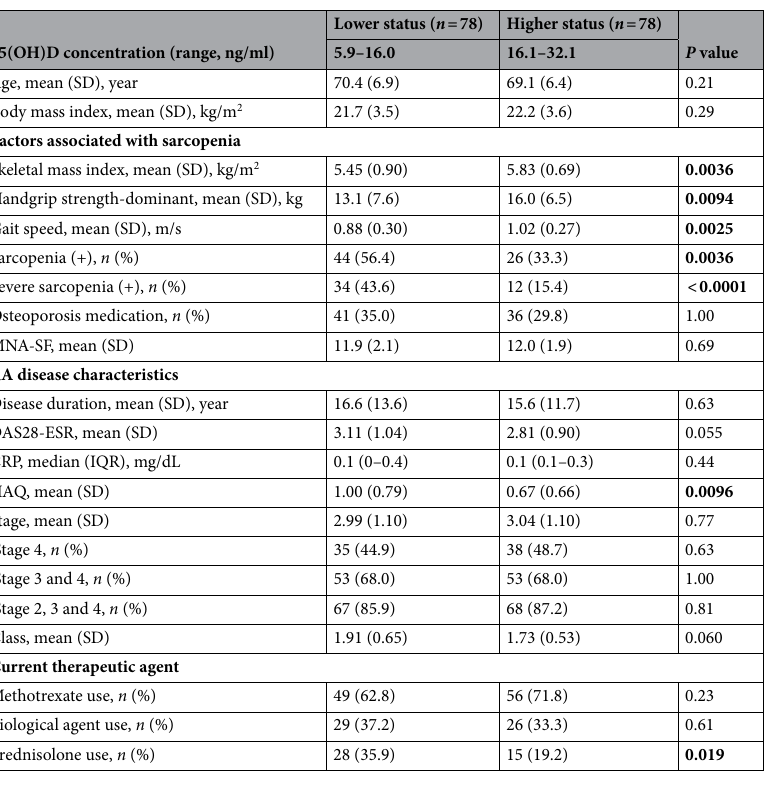
Table 2. Characteristics of participants by serum 25(OH)D status. RA patients are divided into the following two groups by median of serum 25(OH)D: lower status group (25(OH)D: 5.9–16.0 ng/ml) and higher status group (25(OH)D: 16.1–32.1 ng/ml). Data are presented as the mean (± standard deviation) or as the median (interquartile range (IQR)) for continuous variables, and as numbers (%) for categorial variables. RA rheumatoid arthritis, MNA-SF Mini Nutritional Assessment Short-Form, DAS28 disease activity score using 28 joints, VAS visual analogue scale, HAQ health assessment